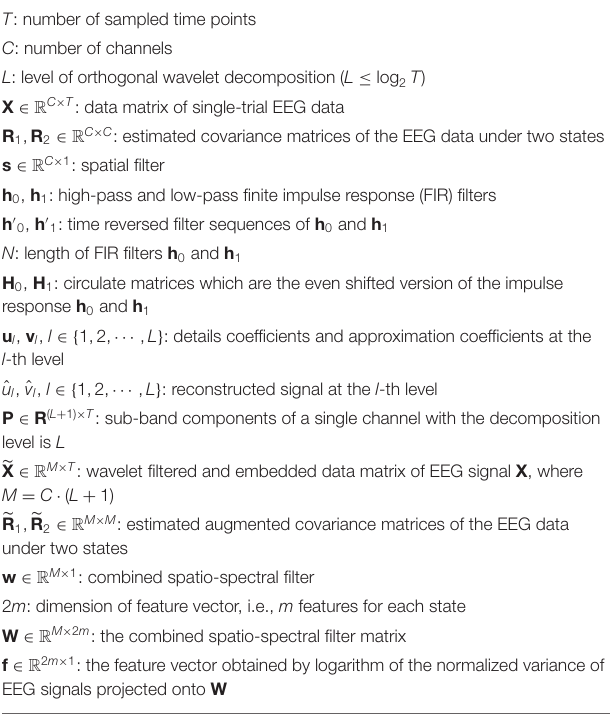
TABLE 1 | List of symbols in the